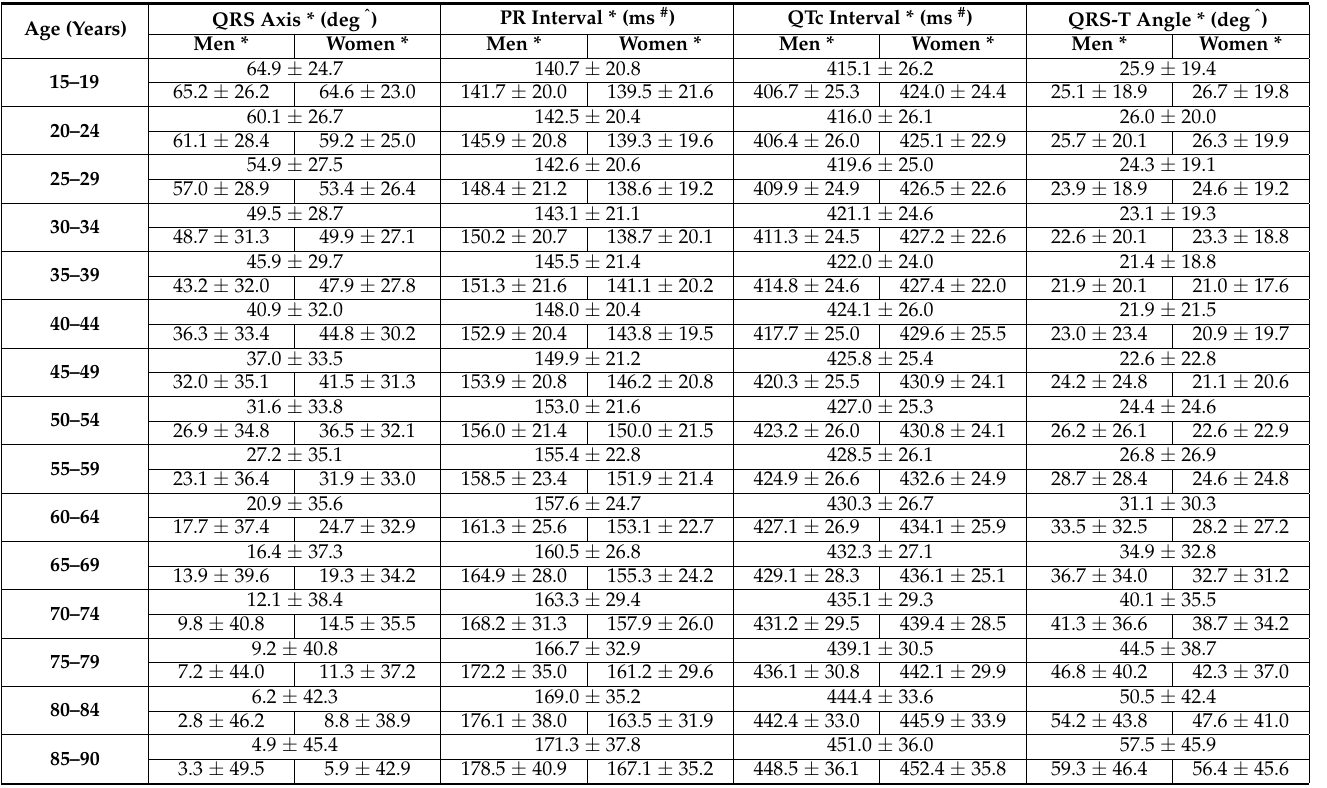
Tables 3 and 4. show, respectively, the mean values ± standard deviation and Z-scores − 2 and +2 (computed in 15 age categories of 5 years each) of parameters with a linear correlation with ageing and of frontal QRS-T angle in the whole population, in males and females. Table 3. Mean ECG values, computed in 15 age categories of 5 years each, of the parameters with a straight-line correlation with age and mean QRS-T angle values. For each age category, in the upper line, means ± standard deviation in the whole population; in the bottom line, means ± standard deviation in males and females.